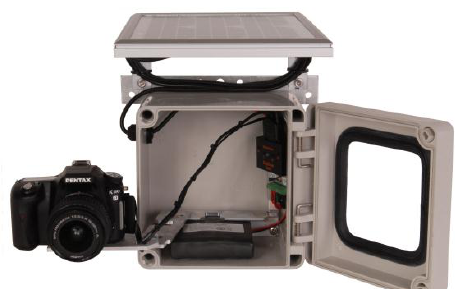
Figure 7. Harbortronic s time lapse package with solar panel (top), SLR camera, time lapse controller (box right in the housing) and buffer battery